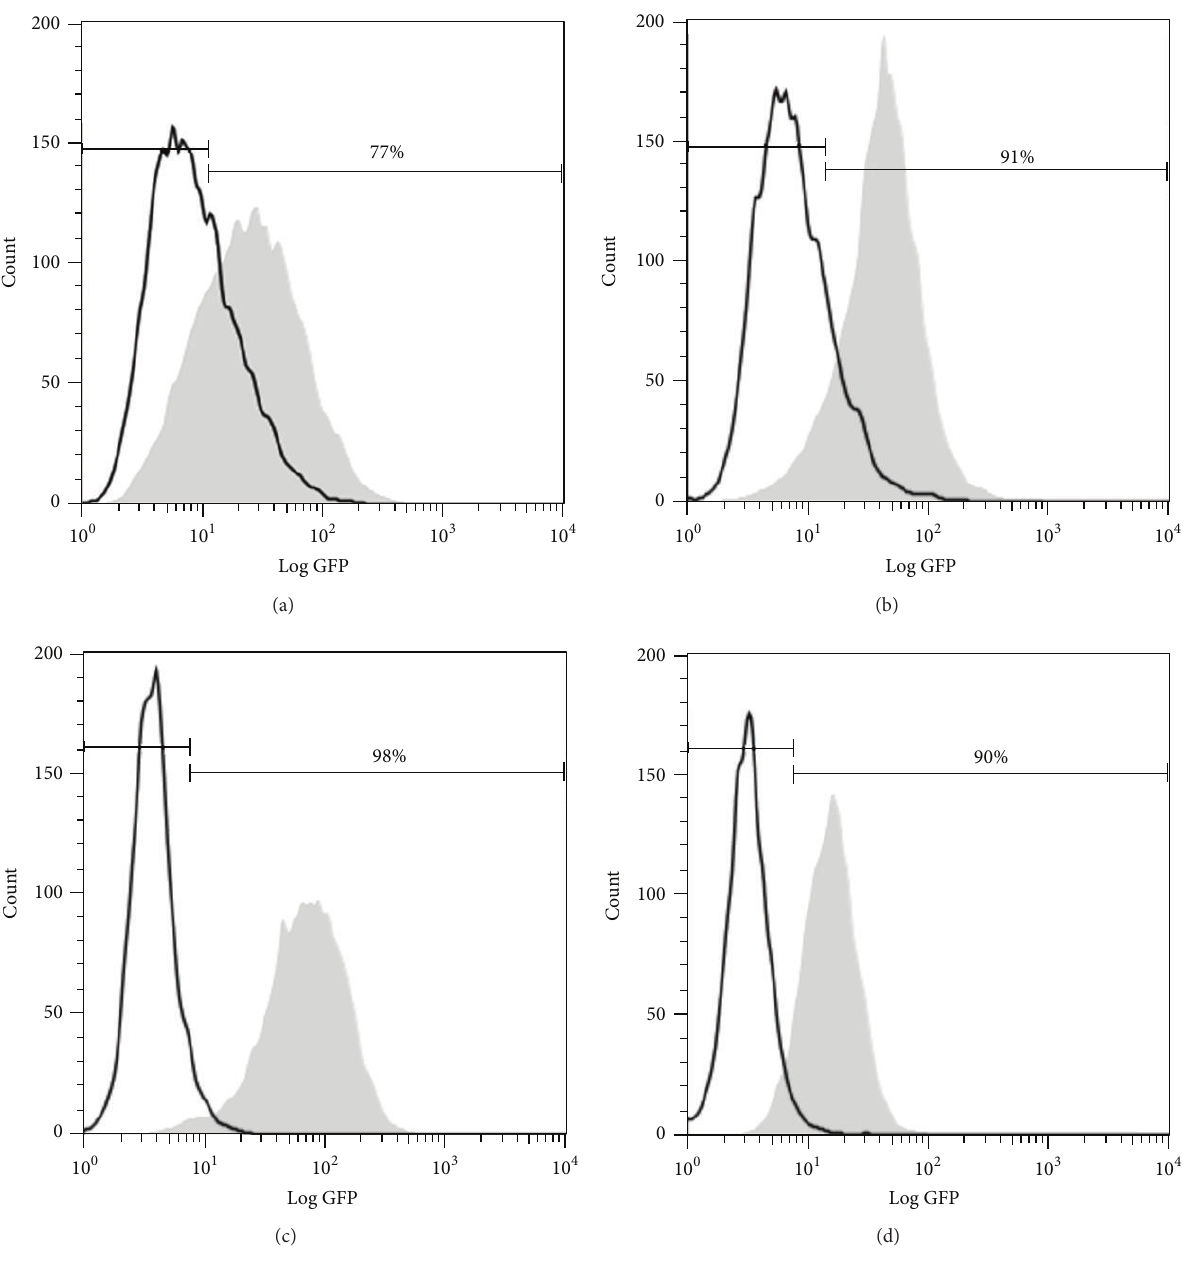
Figure1:ResponseofCaco-2-NF- 𝜅 B-hrGFPD5(a),C3(b),HT-29-NF- 𝜅 B-hrGFPE5(c),andF6(d)clonestoTNF- 𝛼 .Cloneswerestimulated with 50ng/mL TNF- 𝛼 and GFP expression was evaluated by flow cytometry after 48 h. Cell population was gated using the FSC versus SSC dot plot and then represented in a GFP histogram plot. Untreated cells are shown in white while treated cells are shown in grey. The raw data of GFP positive population in treated cells is